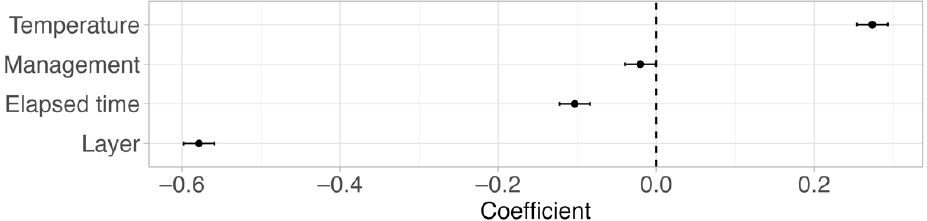
Figure 2. Effect of temperature, management, elapsed time and soil layer on CO 2 emissions. Proba- bility for significance is 0.05.